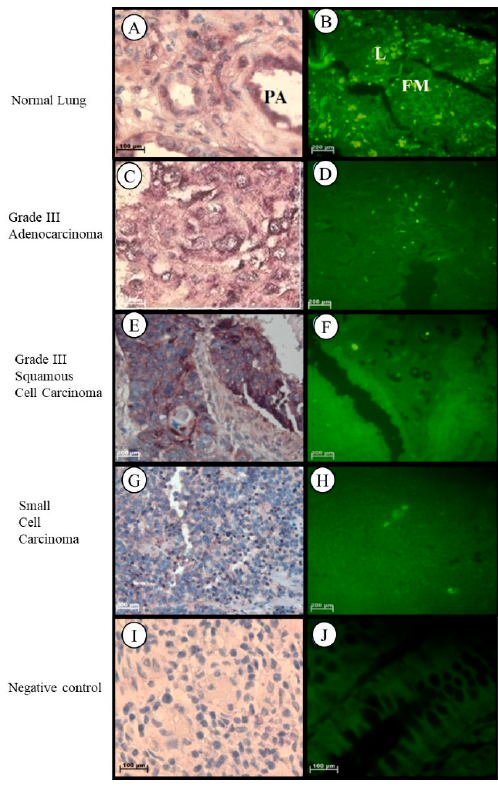
Figure 5. Subcellular Localizations of Tspo mRNA in healthy and diseased lung tissue: In healthy lung tissue ( A , B ) Tspo mRNA is expressed in the cuboidal cells that line the respiratory bronchiole in the smooth muscle fibres surrounding the pulmonary artery (PA), and in the nuclei and cytoplasm of the endothelial cells of the pulmonary artery and lymphocytes (L) in the surrounding stroma (FM). A comparison of the fluorescent intensity shows that there is no significant difference between Tspo expression in cancer ( D , F , H ) and normal lung ( B ) tissue. Grade III lung adenocarcinoma ( C , D ) expresses Tspo mRNA in the cytoplasm and nuclei of tumour cells and in the fibres located in the surrounding solid like stroma. In Grade III squamous cell carcinoma ( E , F ) Tspo mRNA is localized in the cytoplasm and nuclei of tumour cells. In small cell carcinoma ( G , H ) localization occurs in the cytoplasm of tumour cells that resemble lymphocytes and in the nuclei of lymphocytes and endothelial cells lining capillaries in the stroma. ( I , J ) Negative control for the subcellular localization of Tspo mRNA. Sense probes were used to probe tissue preparations and this was analysed colorimetrically and fluorescently . Tissues are magnified at 1000×.